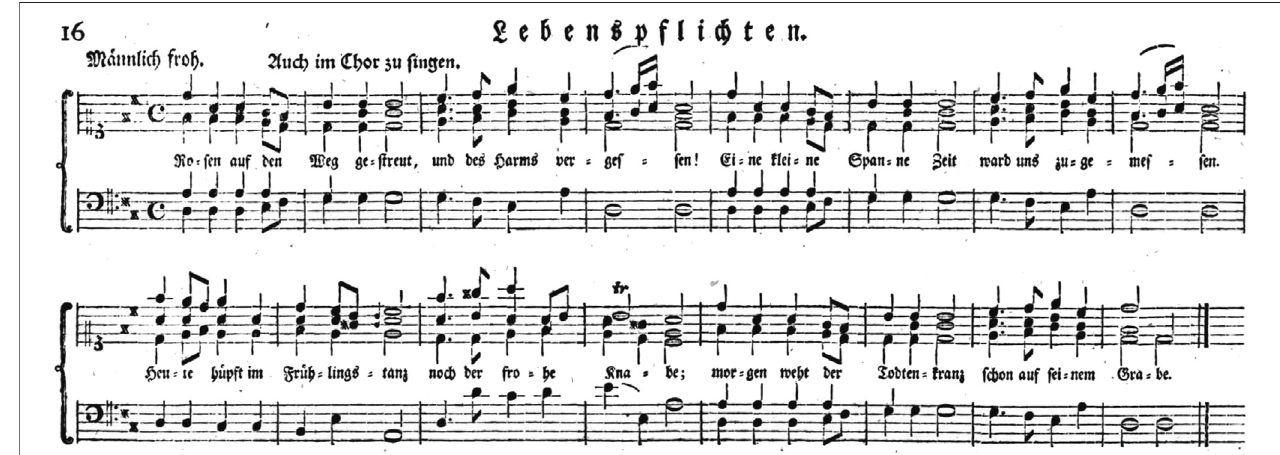
FIGURE 2 | Reichardt, “ Lebensp fl ichten ” (text: Hölty), from Oden und Lieder (volume 10) (Berlin, 1779).